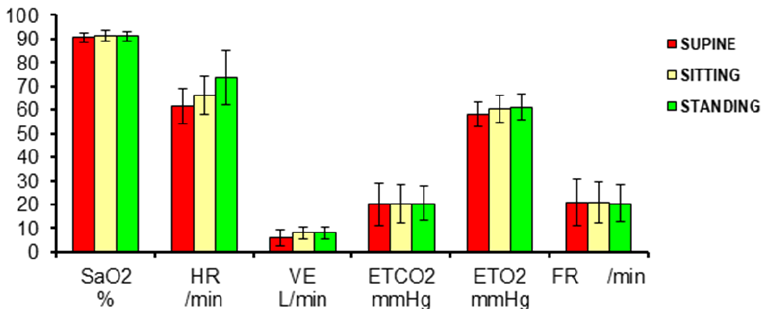
Figure 1. Ventilation and pulse-oximetry studies in the three resting positions: (A) supine (red), (B) sitting (yellow), (C) standing (green) in 15 healthy high-altitude men at 3500 m of altitude. SaO 2 = arterial oxygen saturation from pulse-oximeter, HR = heart rate, VE = ventilation, Body Temperature, Pressure water vapor Saturated (BTPS), ETCO 2 = end-tidal carbon dioxide, ETO 2 = end-tidal oxygen, FR = respiratory frequency.